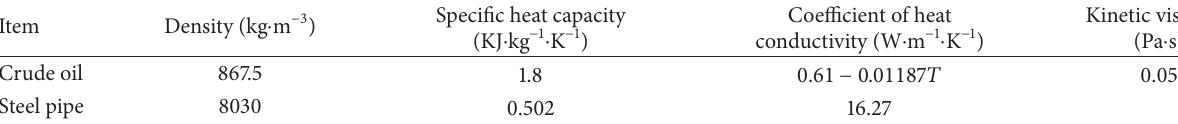
Table 1: Physical characteristics of materials used in simulation.